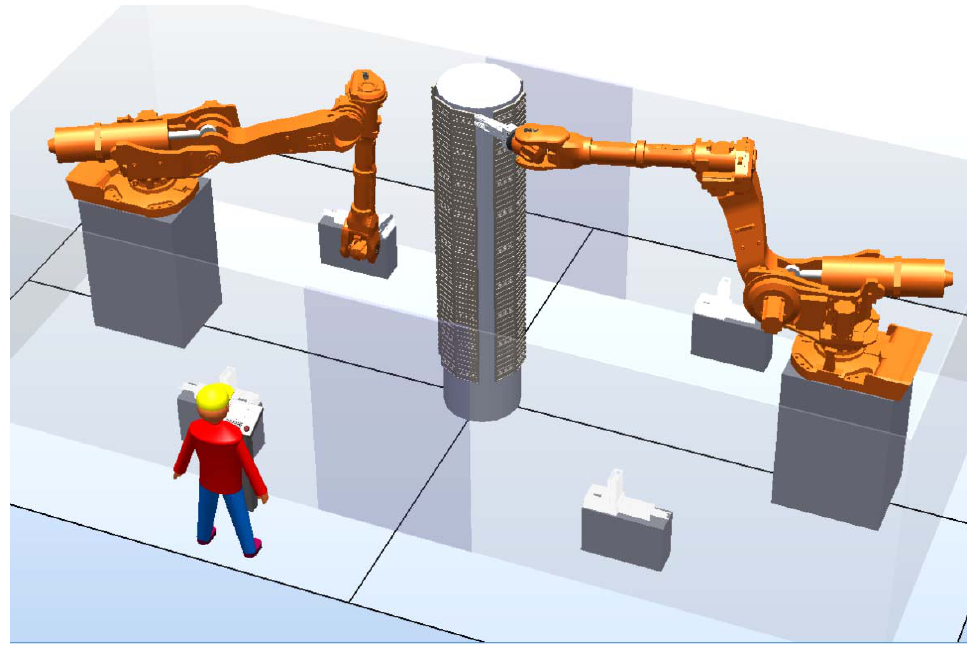
Figure 4. A RobotStudio model of the developed robot